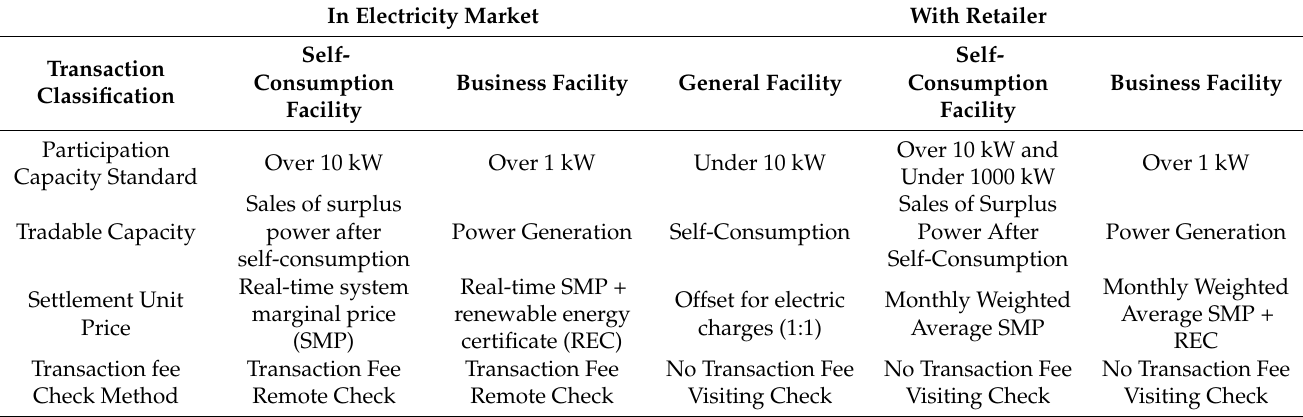
Table 1. Small and mid-sized renewable energy transactions.